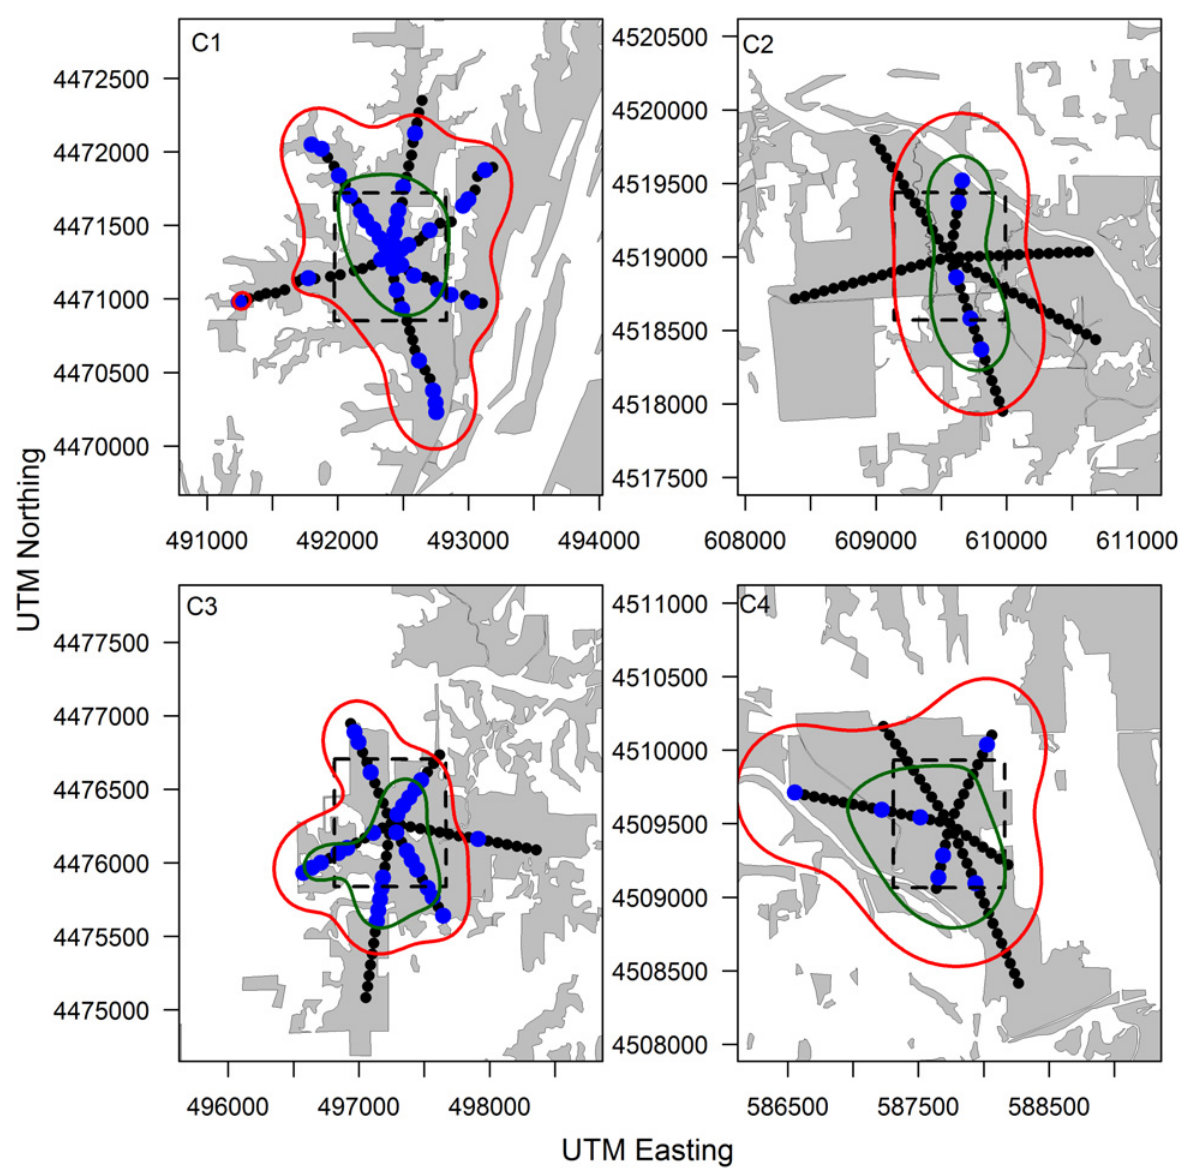
Figure 2. Configuration of control site trapping webs illustrating the distribution of Rhodamine B marked captures (blue), the bait distribution zone (dashed line), and 90% (red) and 50% (green) utilization distributions estimated from the distribution of Rhodamine B marked raccoons. Transects were oriented through forested areas (gray) and did not extend into agricultural areas (white) based on limited use of agricultural interiors by raccoons in our study area. Each panel represents a unique study site where Rhodamine B baits were placed in a uniform distribution within the bait distribution zone (dashed